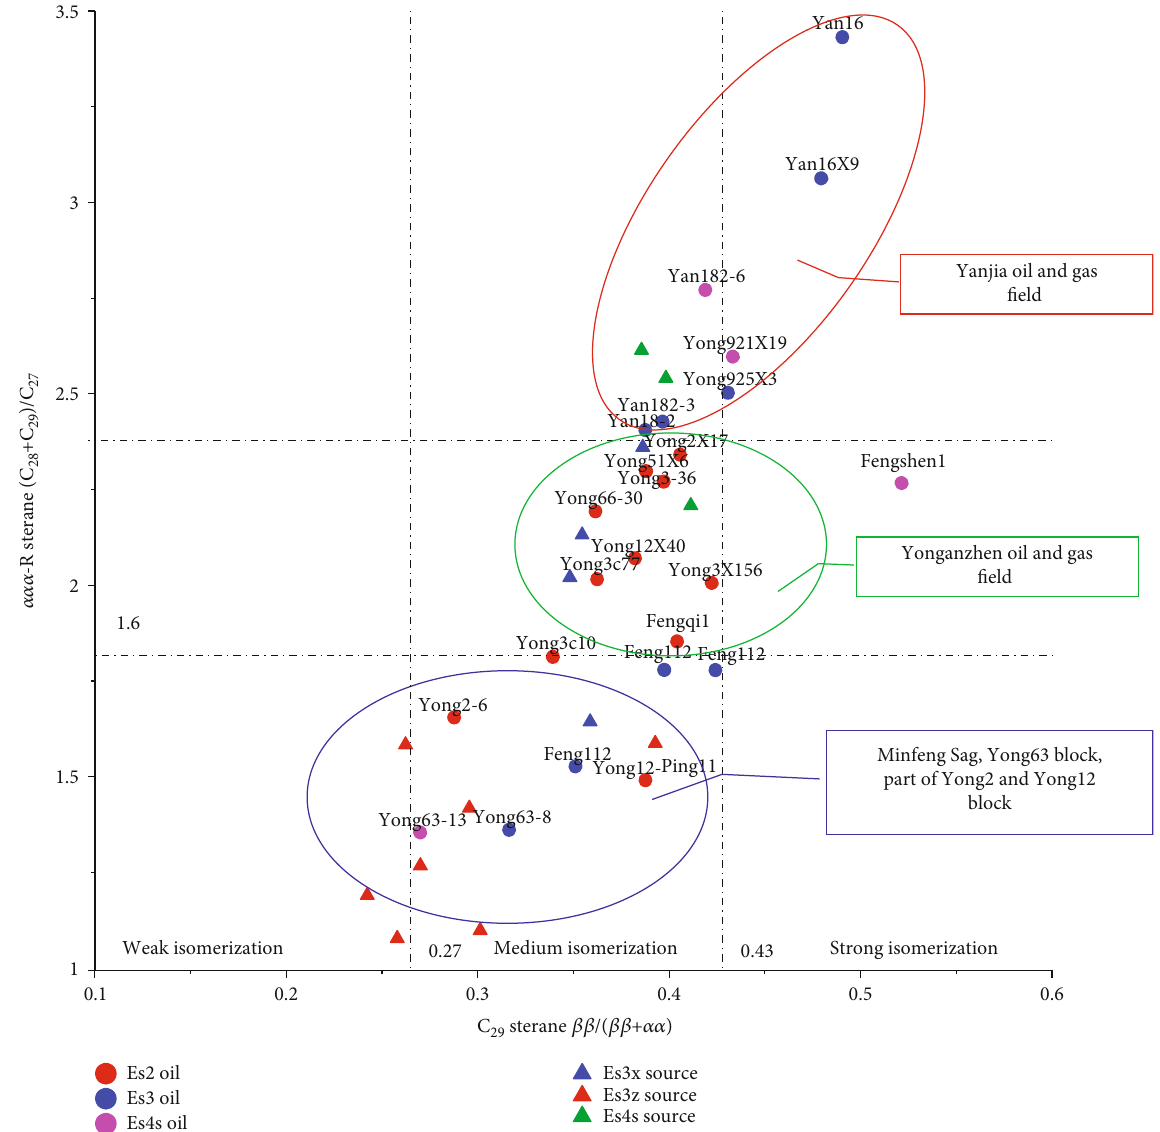
+ C /C C sterane ββ / ð ββ + αα Þ 28 29 27 and 29